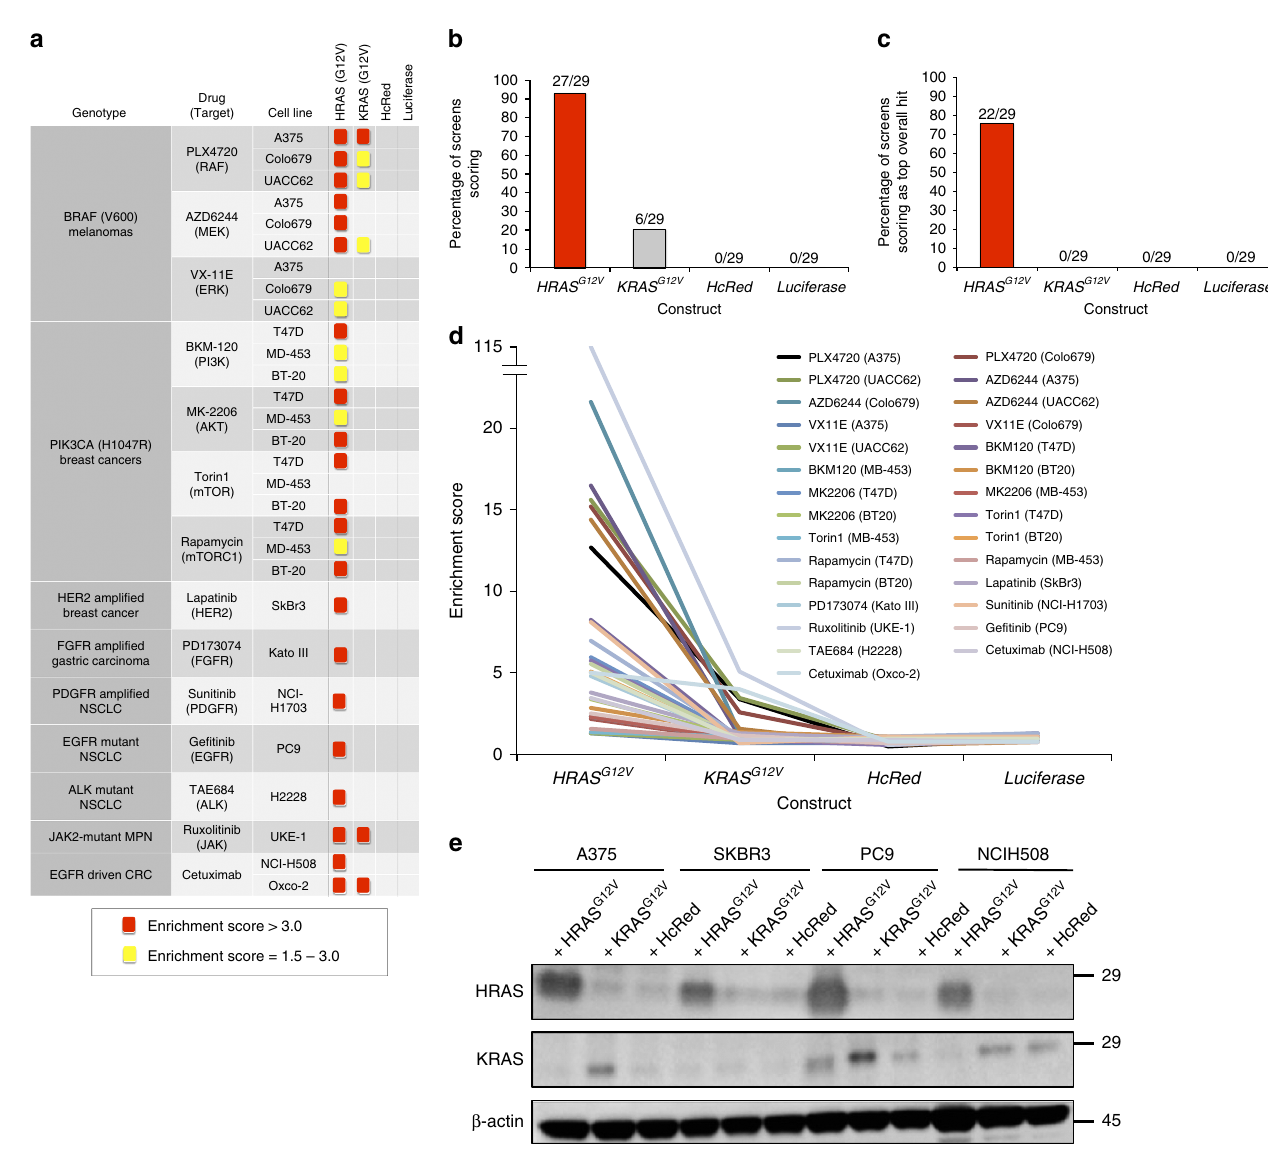
Figure 1 | Pathway activating screens reveal differential resistance conferring potential between ectopic HRAS G12V and KRAS G12V . ( a ) Enrichment scores for four lentivirally delivered cDNA constructs (encoding HRAS G12V , KRAS G12V , HcRed and Luciferase ) across 29 resistance screens involving diverse kinase inhibitors and cell lines. Enrichment scores reflect the relative abundance of each construct in the presence of drug normalized to the same value in the absence of drug, with scores exceeding 1.5 considered to be indicative of resistance. ( b ) Percentage of screens in a in which indicated constructs scored (enrichment score 4 1.5). ( c ) Percentage of screens in a in which indicated constructs scored as the top overall hit from a library of 40 pathway activating constructs and controls. ( d ) Enrichment score for each construct in each screen. ( e ) Immunoblot analysis with antibodies against HRAS, KRAS or b -actin using extracts isolated from the indicated cell lines stably transduced with a vector encoding the indicated transgene. Images are cropped for